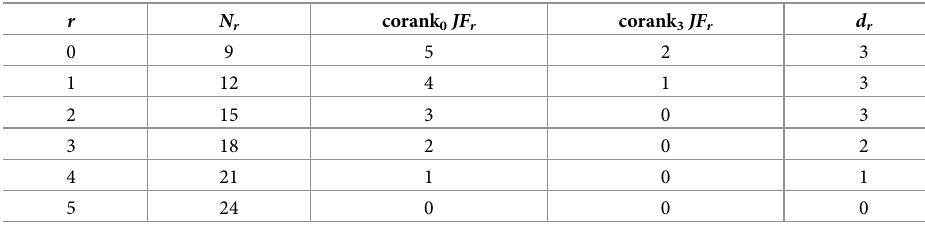
Table 2. Summary of computations showing the model (5) is identifiable. r